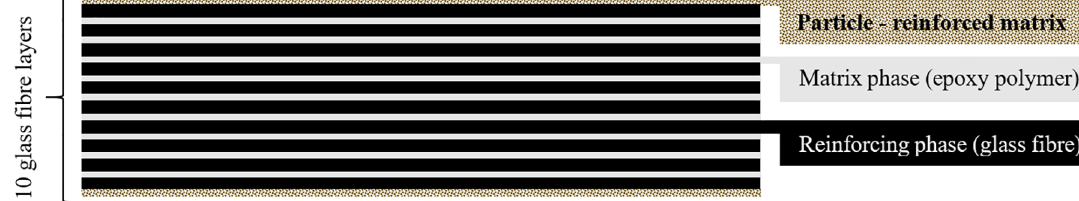
Figure 1. Illustration of the composite stacking